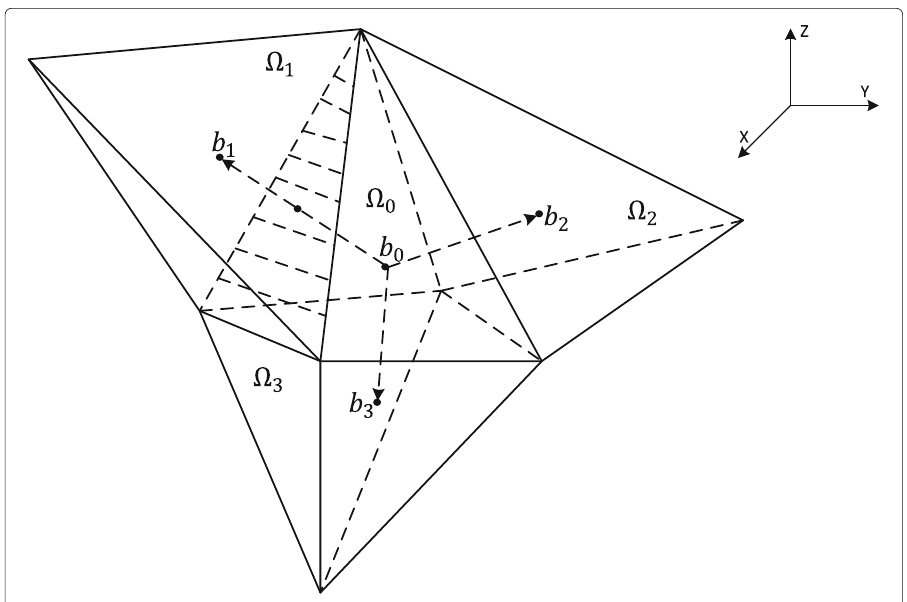
Fig. 2 Geometry information for 3D Euler indicating on unstructured